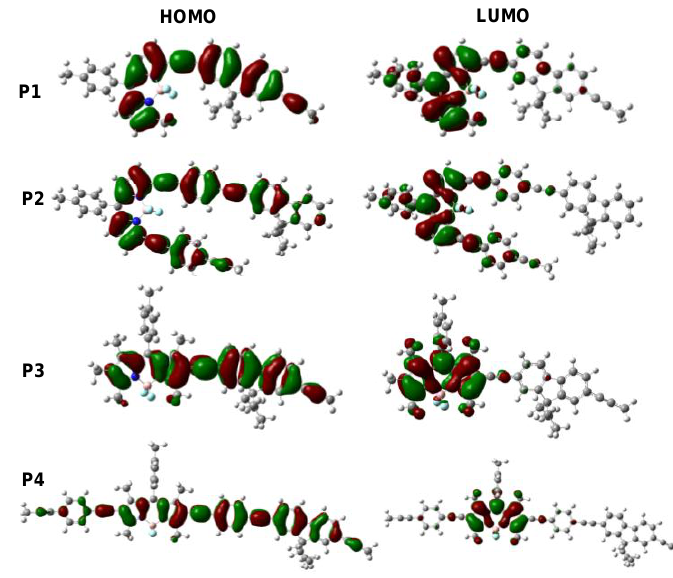
Figure 5. Frontier molecular orbitals of polymers using DFT evaluated at the B3LYP/6-31G(d) level.